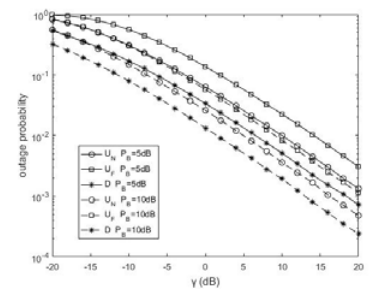
Fig. 4. Outage probability against γ